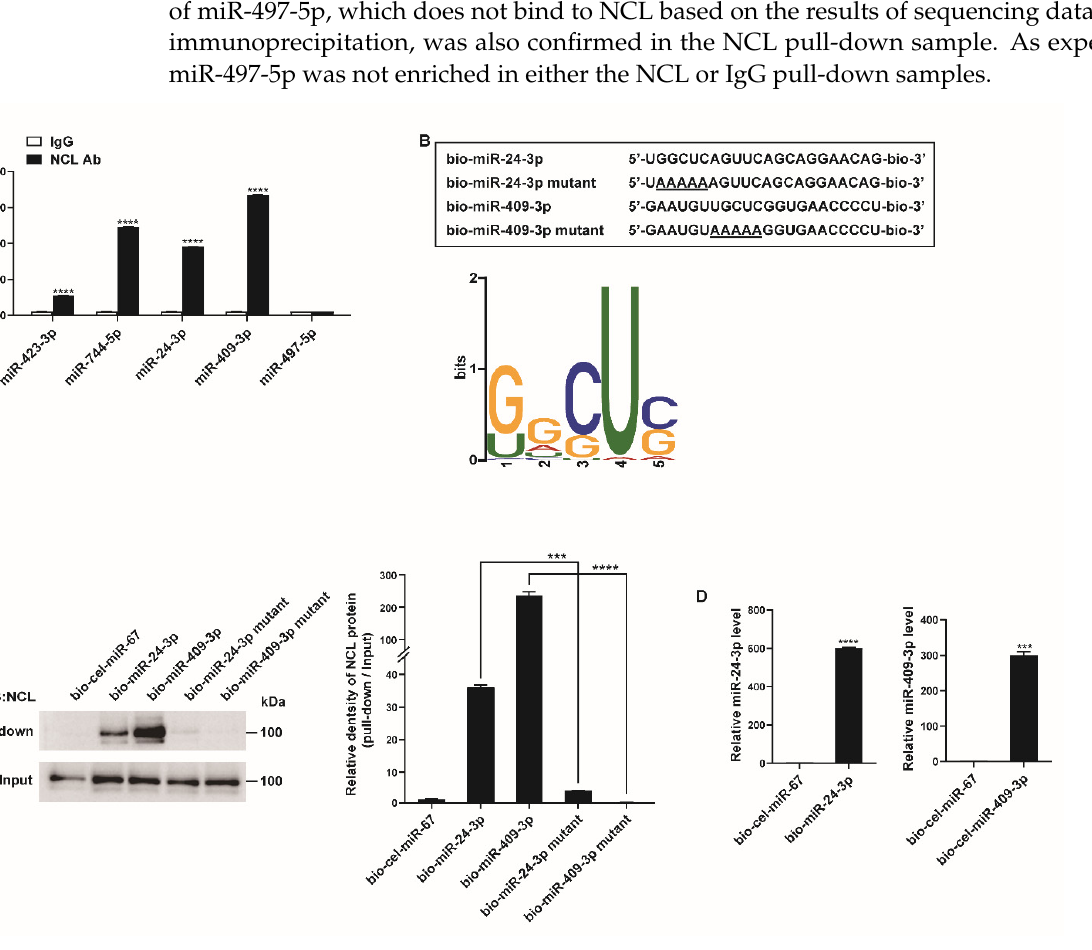
Figure 3. NCL binds to a subset of miRNAs. ( A ) PASMCs were subjected to RNA immunoprecipitation assay using an anti − NCL antibody. qRT − PCR was then performed to measure the enrichment of the indicated miRNAs. Levels of miRNAs relative to SNORD61 were quantitated. The data represent the mean ± S.E. of triplicate measurements of three independent experiments. ( B ) ( Upper panel ) Schematic diagram of miRNA wild type and mutant sequences. Underlined characters indi ‐ cate mutations introduced. ( Lower panel ) Sequence logo representing the conserved motif present in miRNAs associated with NCL. The overall height of each stack indicates the sequence conserva ‐ tion at that position (measured in bits). ( C ) Immunoblot analysis using anti − NCL antibodies for the pull − down and input (1%) samples from PASMCs transfected with biotinylated miRNAs or bioti ‐ nylated miRNA mutants containing the mutated motif sequence. ( D ) Levels of miR ‐ 24 ‐ 3p or miR ‐